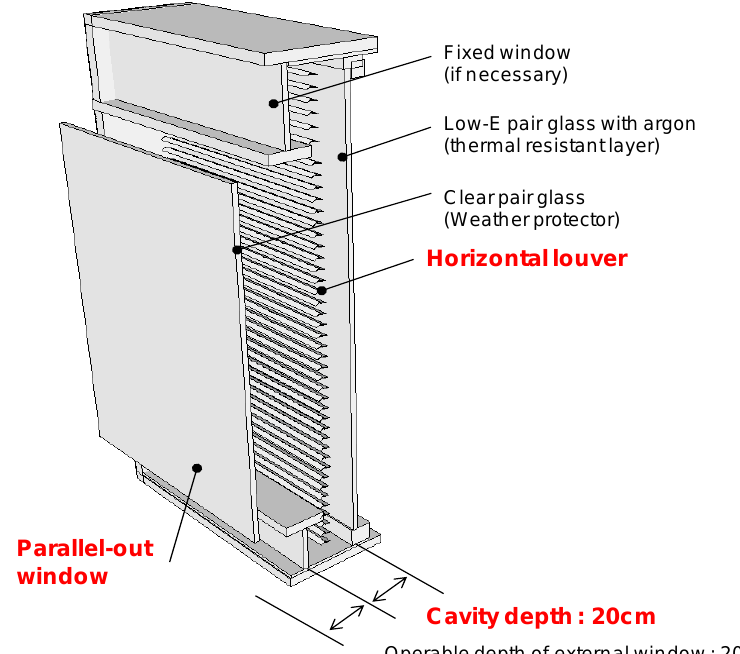
Figure 1. Conceptual geometry of the DWCS.